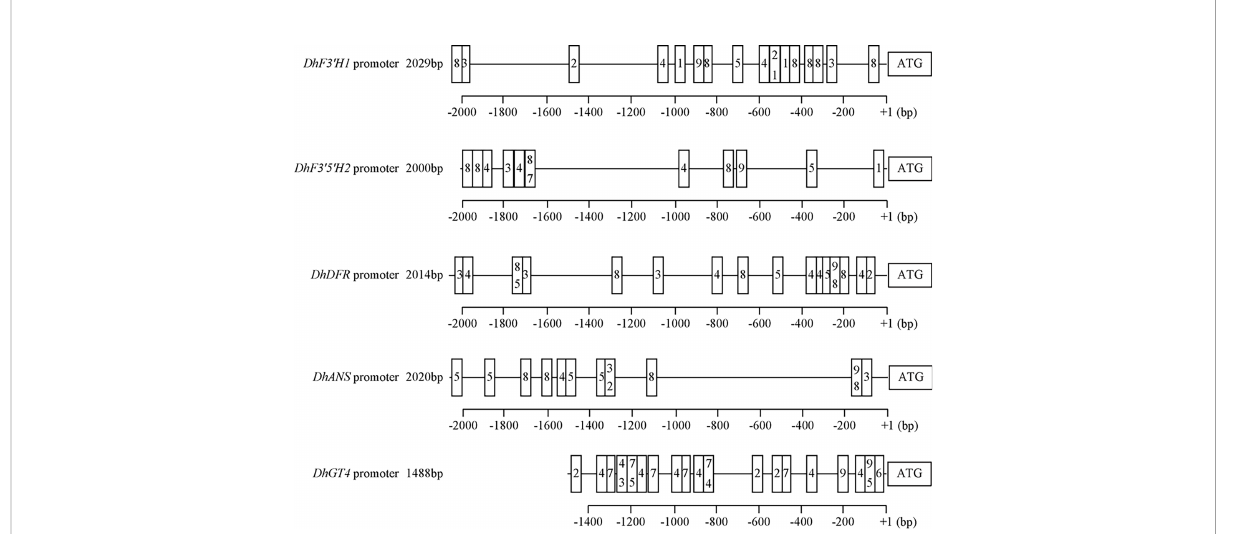
FIGURE 6 Schematic diagram of MYB and bHLH binding-site motifs predicted in the promoters of ABP structural genes. Possible cis -regulatory elements recognized by MYB or bHLH were predicted using the promoter regions of DhF3 ’ H1 , DhF3 ’ 5 ’ H2, DhDFR , DhANS , and DhGT4 , respectively. Numbers in boxes indicate potential MYB binding-site motifs: 1, MRE; 2, MYBPLANT; 3, MYBPZM; 4, MYBCORE; 5, MYB1AT; 6, MBSI; 7, MBS; and potential bHLH binding-site motifs: 8, E-box; 9, G-box.